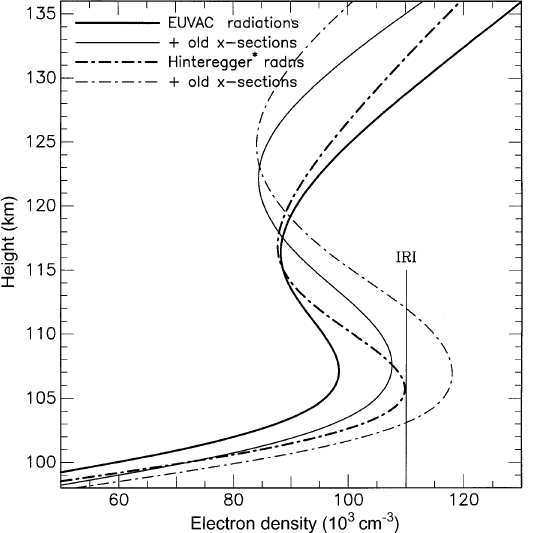
Fig. 6. E-region profiles calculated for summer noon conditions, as in Fig. 5. Continuous lines use the EUVAC radiation model, with ‘normal’ ( heavy line ) or reduced ( fine line ) ionisation cross-sections. Chain lines give corresponding results for the modified Hinteregger radiations of Richards and Torr (1984,